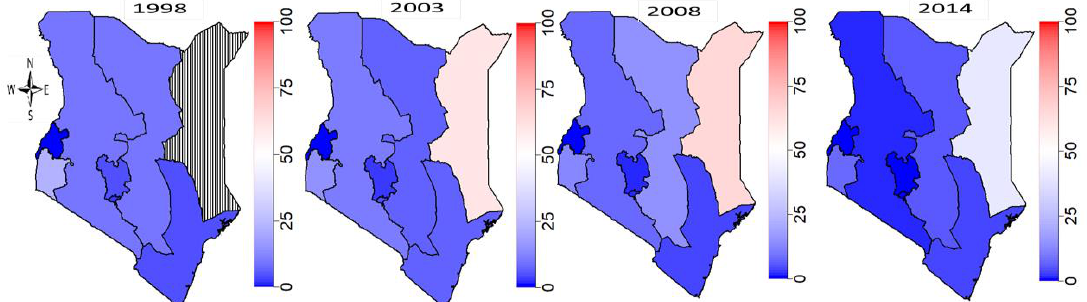
Figure 2. Evolution of FGM / C prevalence among 0–14 years old girls in Kenya from 1998 to 2014. Note that in 1998, there were no surveys in the North Eastern region hence the black-white stripes. Across the years, red regions had highest prevalence which decreased in magnitude as it fades through red to deep blue.